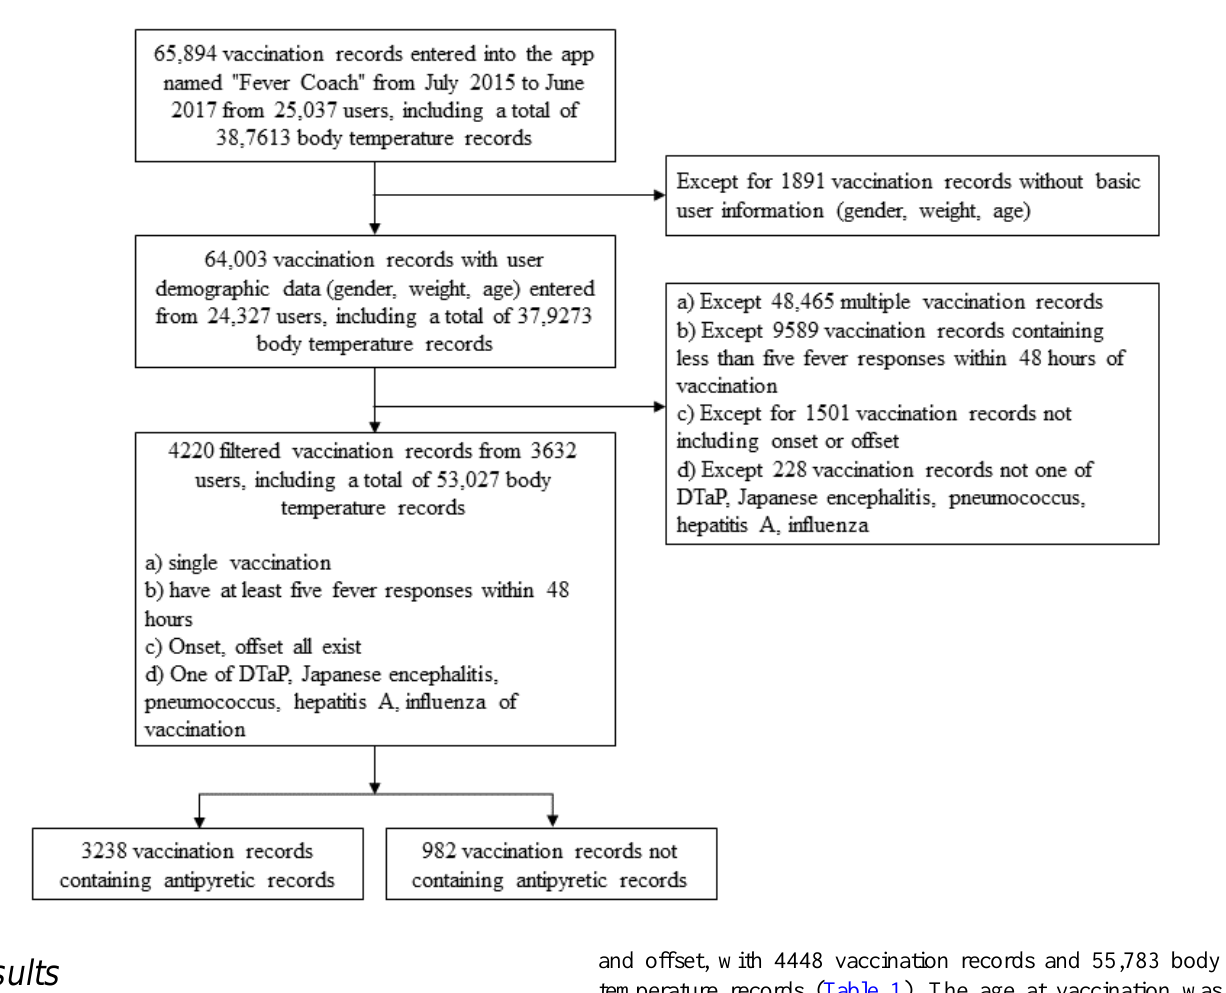
Figure 3. Data collection